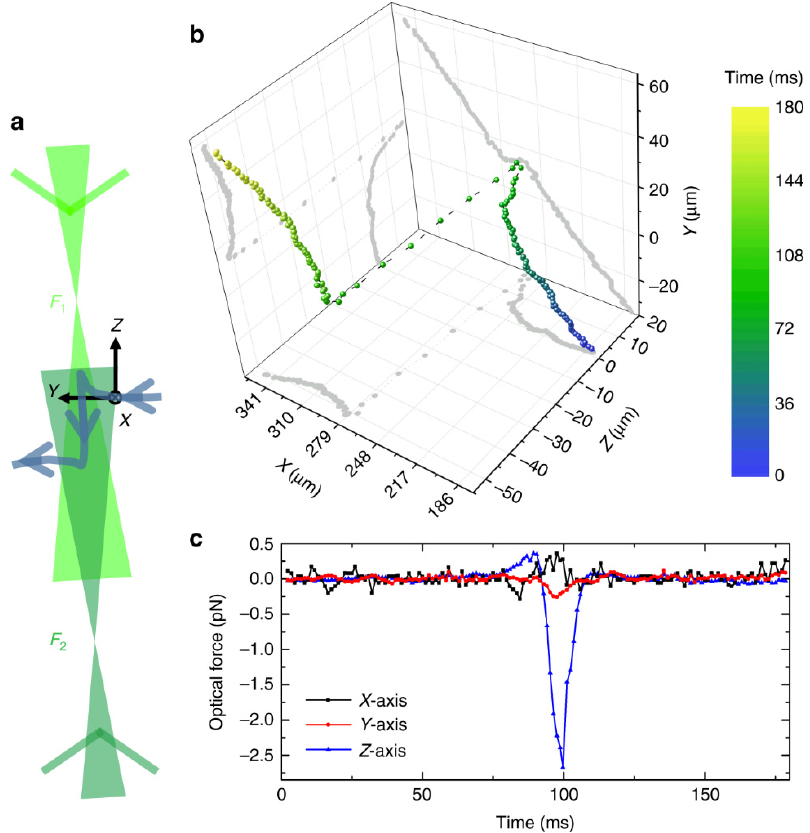
Figure 13. Particle motion under the influence of an external optical force. ( a ) Sketch of the trajectory (blue trace with arrows) of an 800 nm PSL sphere crossing a CPT (green laser beams). F 1 and F 2 are the foci of the two laser beams. The arrow on each laser beam indicates their propagation direction. The CPT is slightly tilted with respect to the Z-axis. The origin of the coordinate system corresponds to the focus of the holography laser beam. ( b ) Colored dots: Center-of-mass coordinates of the sphere as a function of time. The color code indicates the time. Gray curves: 2D projections on the respective planes. For the sake of clarity, the temporal distance between adjacent coordinate points has been chosen to be 1.2 ms. Note that the time resolution of the holograms is much better (240 µs). ( c ) Optical forces in X-direction, Y-direction, and Z-direction as a function of time (reprinted from [200], with permission under Creative Commons Attribution license, Copyright (2018) Nature).